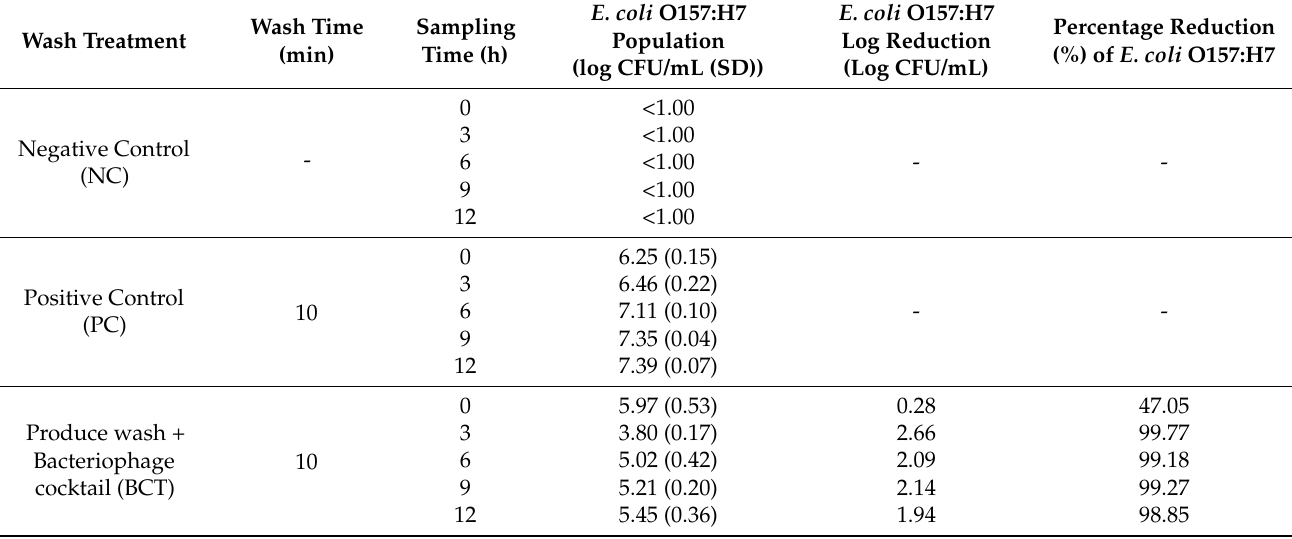
Table 1. Reduction of E. coli O157:H7 (ATCC 35150) on spinach via postharvest pathogen control measures when using bacteriophage cocktail wash solution made with potable water in a simulated dunk tank. The data and standard deviation (SD) represent the mean of triplicate replication.